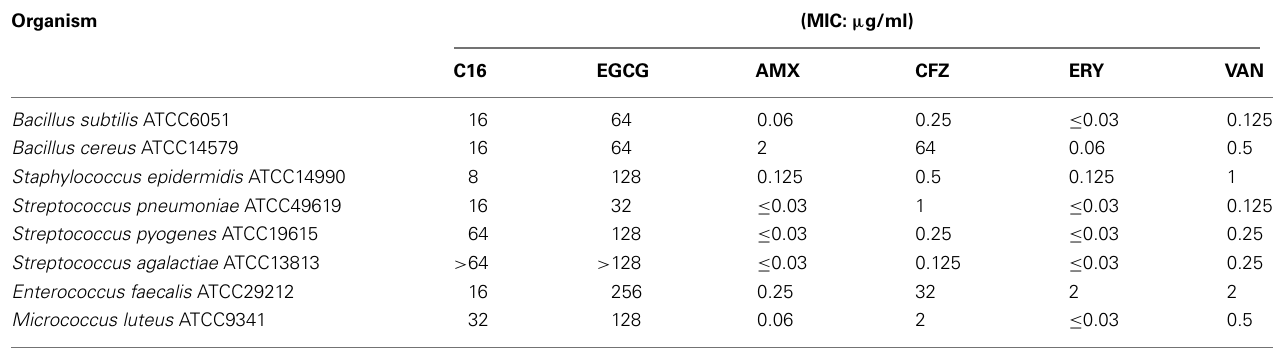
Table 3 |Antibacterial activities of C16 against Gram-positive